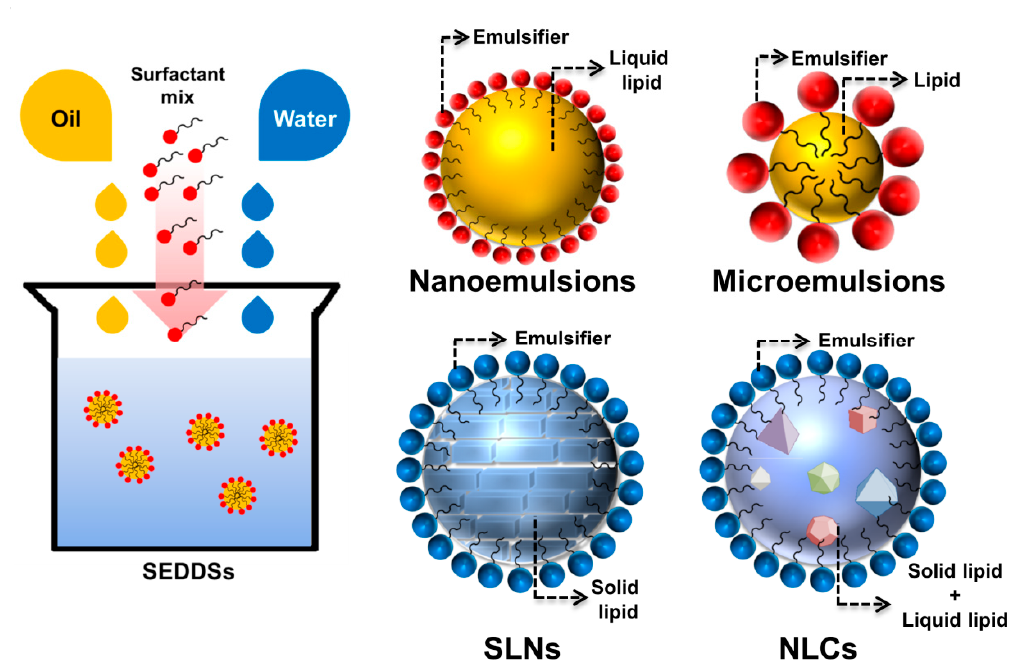
Figure 1. Structures of lipid-based nanoparticles: self-emulsifying drug delivery systems (SEDDSs), nanoemulsions, microemulsions, solid lipid nanoparticles (SLNs), and nanostructured lipid carriers (NLCs).